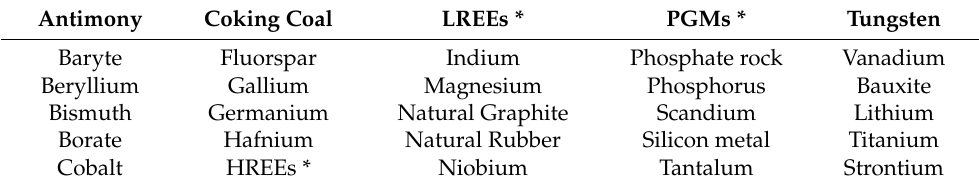
Table 1. The 2020 List of Critical Raw Materials in the European Union [8].